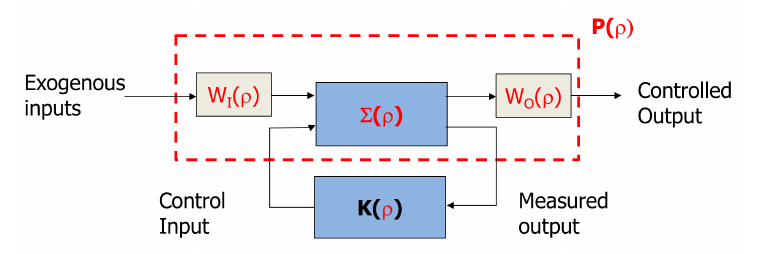
Figure 9. LPV General Control Configuration.